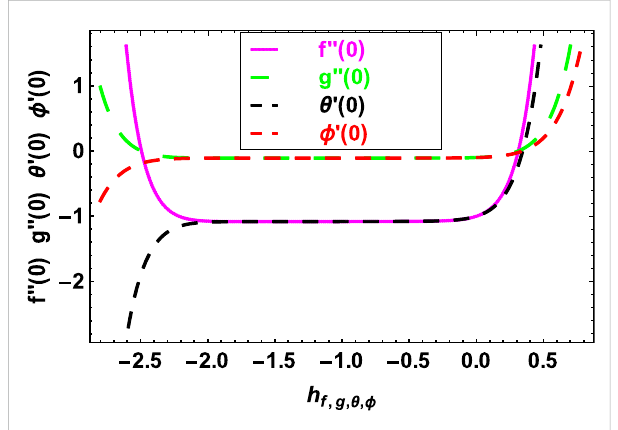
FIGURE 2 - − curves for -